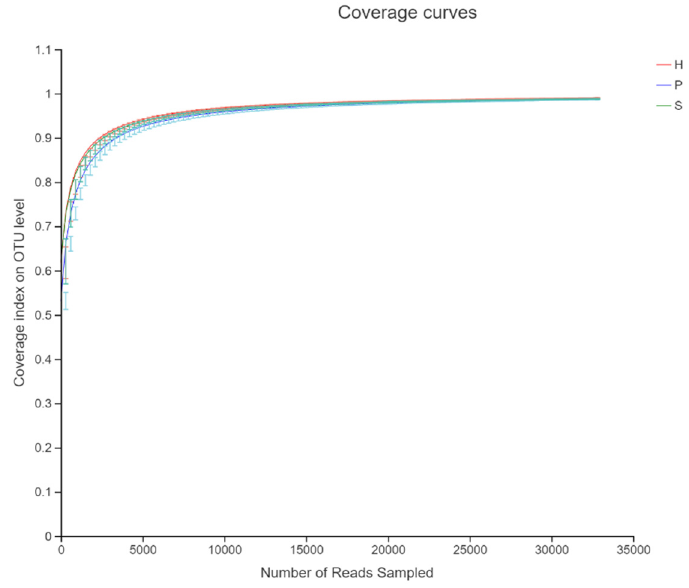
Figure 1. Asymptotes of the rarefaction curve (coverage index) compares sequencing depth between three dietary patterns.